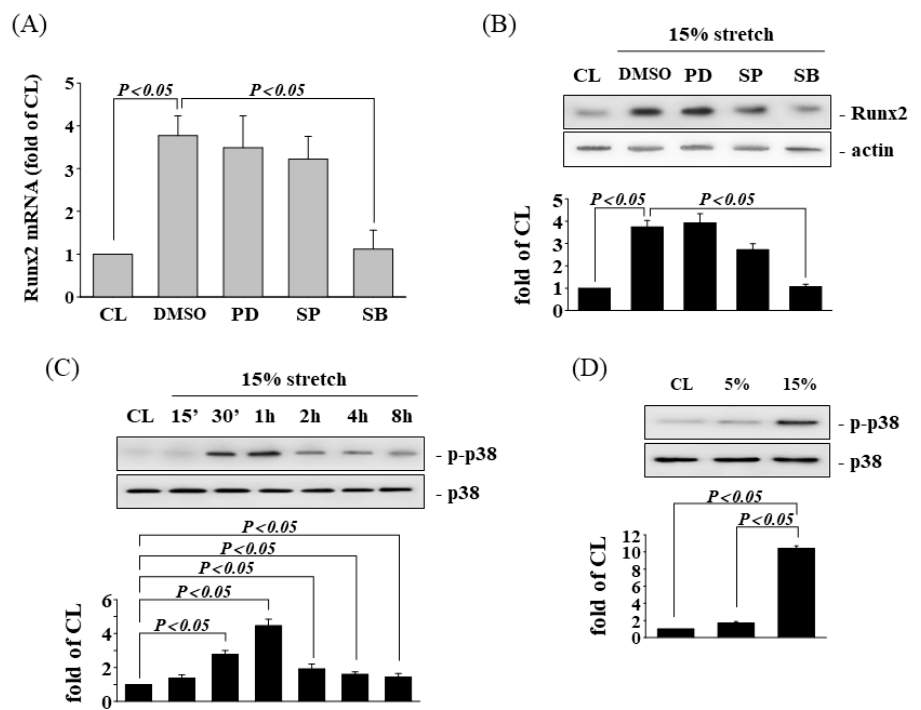
Figure 5. HCS-induced Runx2 expression is p38 MAPK dependent. AF cells were maintained in static conditions as CL or subjected to HCS for 8 h. Before being kept as CL or subjected to CS, AF cells were pretreated with DMSO, or specific kinase inhibitors for ERK1/2 (PD98059, 30 µM), JNK (SP600125, 20 µM), or p38 (SB203580, 10 µM) for 1 h and then subjected to HCS for 8 h. The mRNA ( A ) and protein ( B ) expression of Runx2 were determined by real-time PCR and Western blotting, respectively. ( C ) Control or HCS-stimulated AF cells were maintained for the times indicated, and the phosphorylation of p38 in these cells was determined using Western blotting. ( D ) The phosphorylation of p38 in AF cells after 1 h of LCS (5%) or HCS (15%) stimulation was examined using Western blotting. The results are mean ± SD and are representative of three independent experiments (n = 3). Data statistics were completed with ANOVA followed by Scheffe’s test. The results were considered significant for p < 0.05.